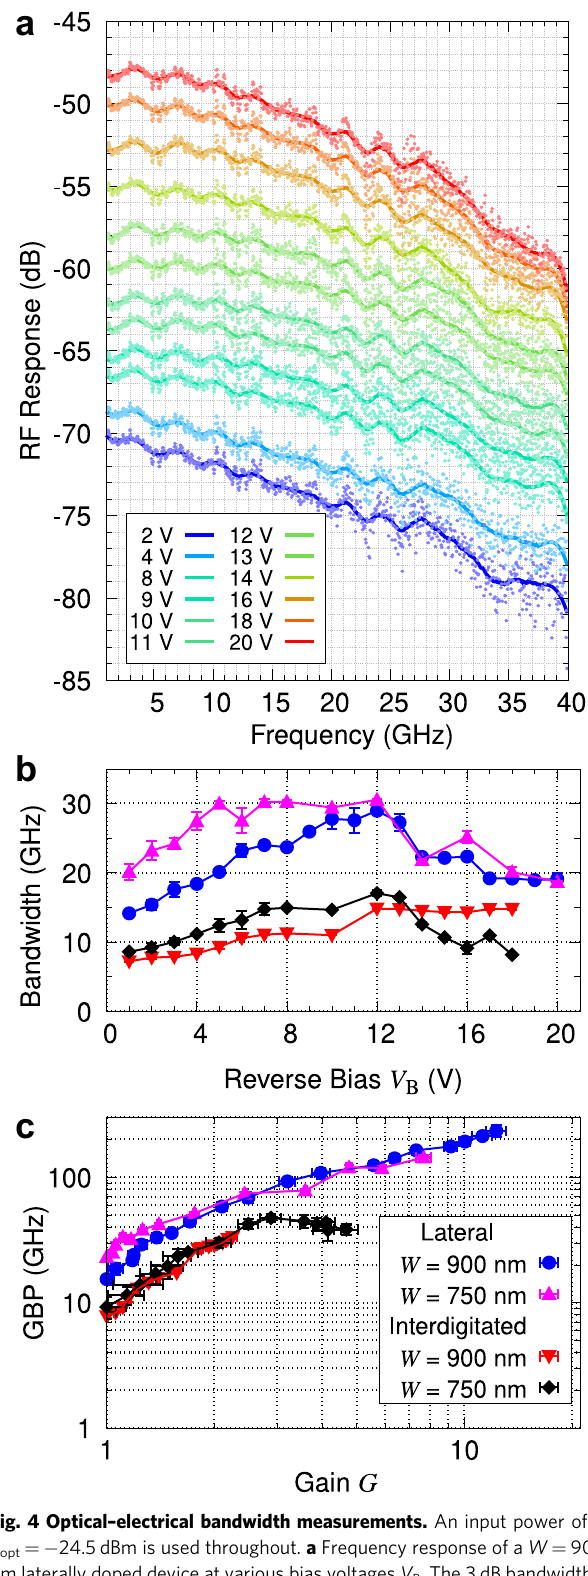
Fig. 4 Optical – electrical bandwidth measurements. An input power of P = − 24.5 dBm is used throughout. a Frequency response of a W = 900 opt nm laterally doped device at various bias voltages V B . The 3 dB bandwidth is obtained from a smoothing fi t to the data points (see Methods). b , c The 3 dB bandwidth and gain-bandwidth product (GBP), respectively, for different device types. Both plots share the same legend shown in c . Each data point and error bar in both plots represent the mean and standard deviation, respectively, of several